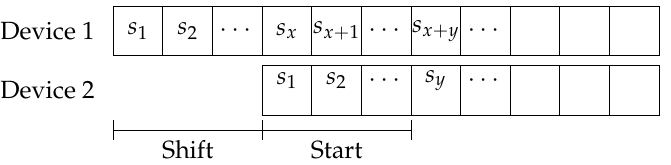
Figure 1. Slot structure used to obtain the CDFs.